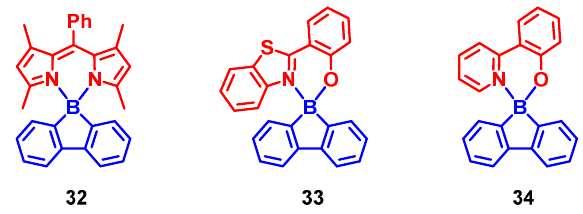
Figure 11. Borafluorene-ligand dyads showing SOCT-ISC.